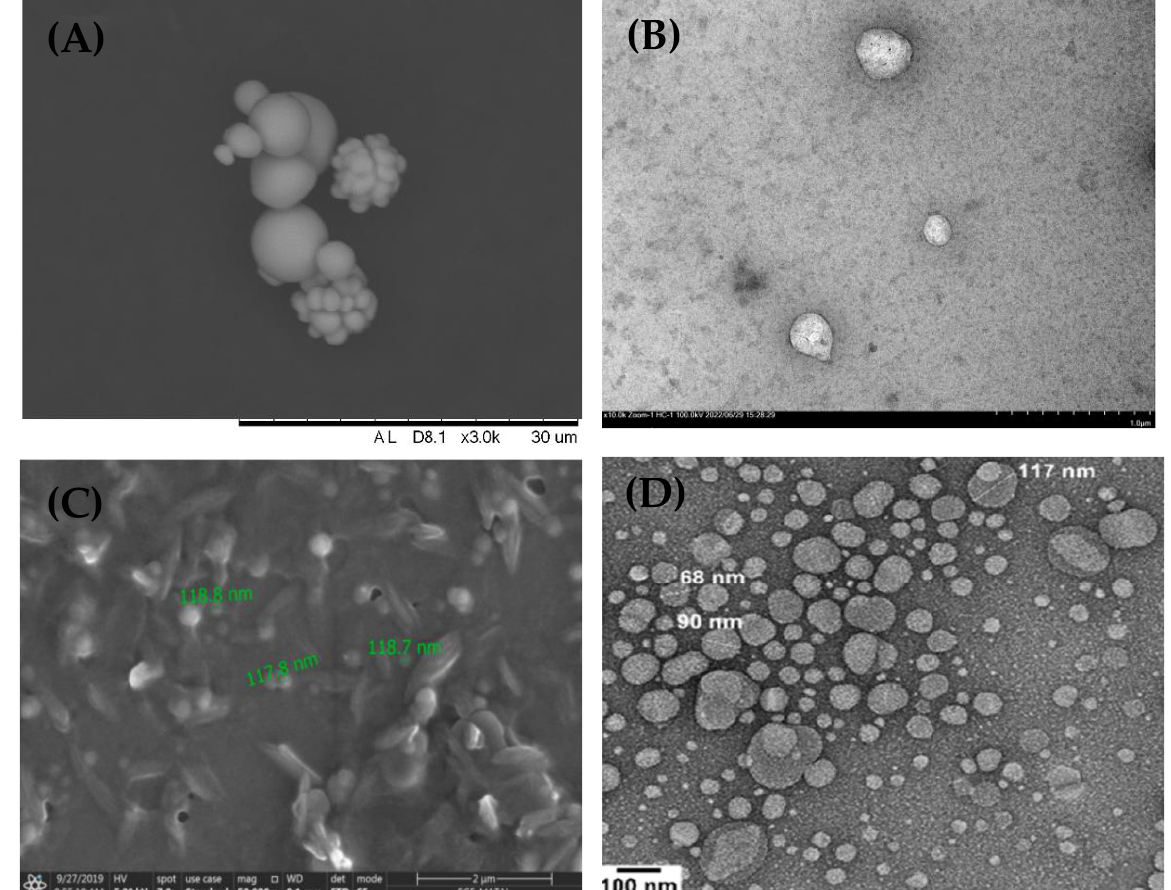
Figure 2. The morphological characterization of SLNs by SEM ( A ) and TEM ( B ) [45]. The morphological characterization of NLCs by SEM ( C ) [70], and TEM ( D ) [71].